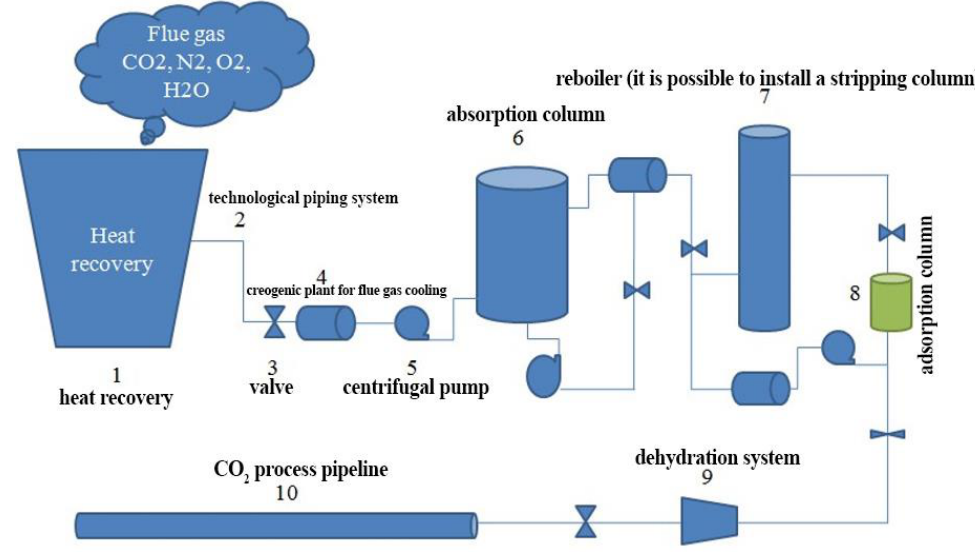
Figure 2. Diagram of a CO 2 capture plant.